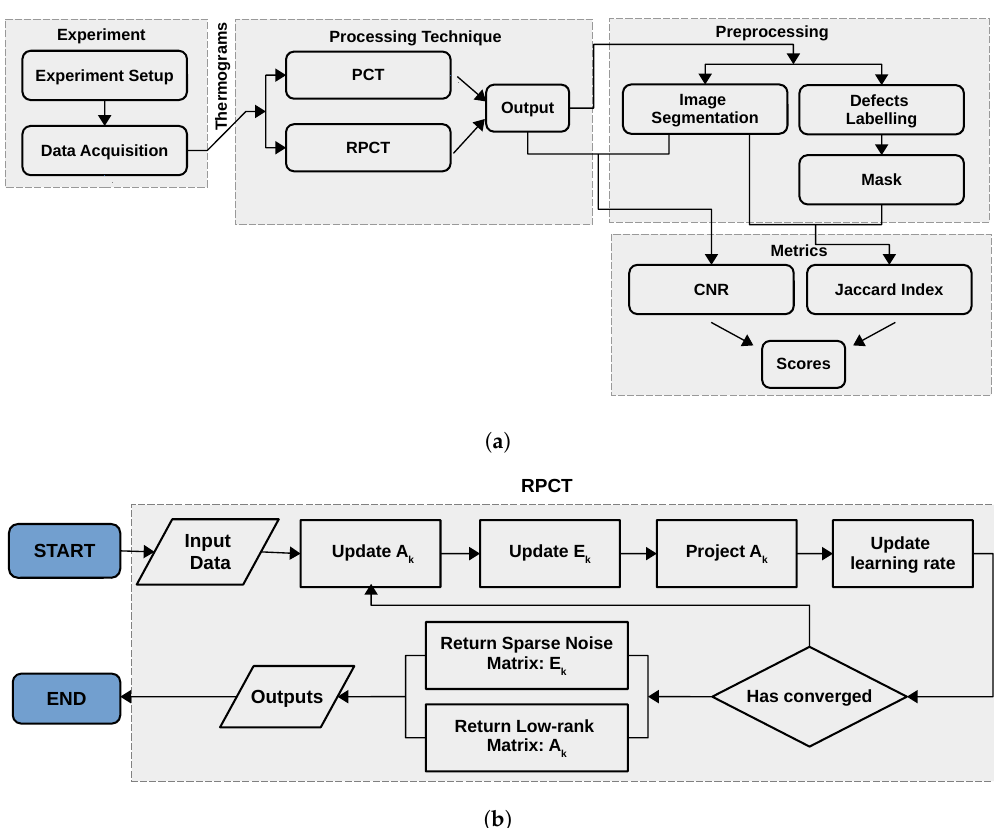
Figure 1. ( a ) Research block diagram; and ( b ) proposed method block